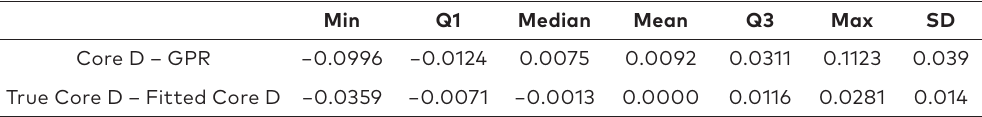
Table 5. Descriptive characteristics of model